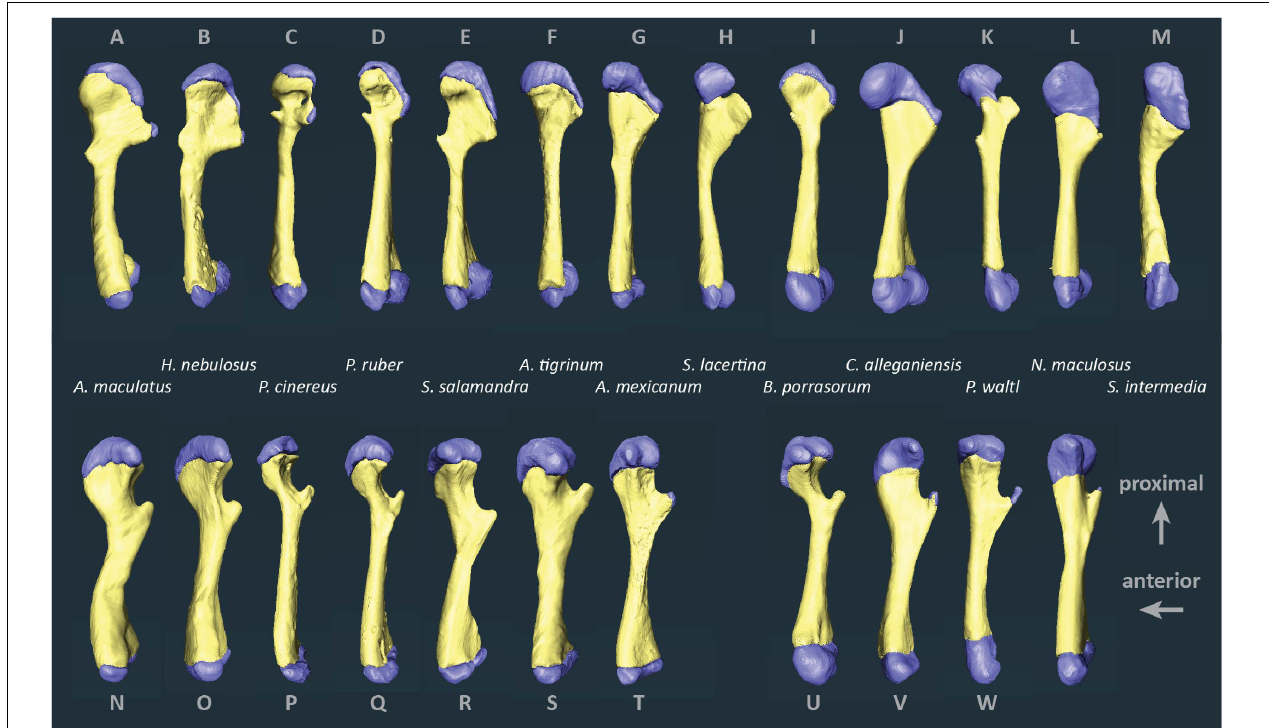
FIGURE 2 | Segmented humeri and femora of scanned salamanders showing mineralized and cartilaginous elements. Surface renderings of left humeri (A–M) and left femora (N–X) in dorsal view showing bone (yellow) and cartilage (blue). Taxa are ordered by average cartilage correction factor in the humerus and femur (total cartilage thickness divided by length of the bony shaft), with the smallest factor on the left ( A. maculatum, 11.4%) and the largest on the right ( S. intermedia , 50.5%).